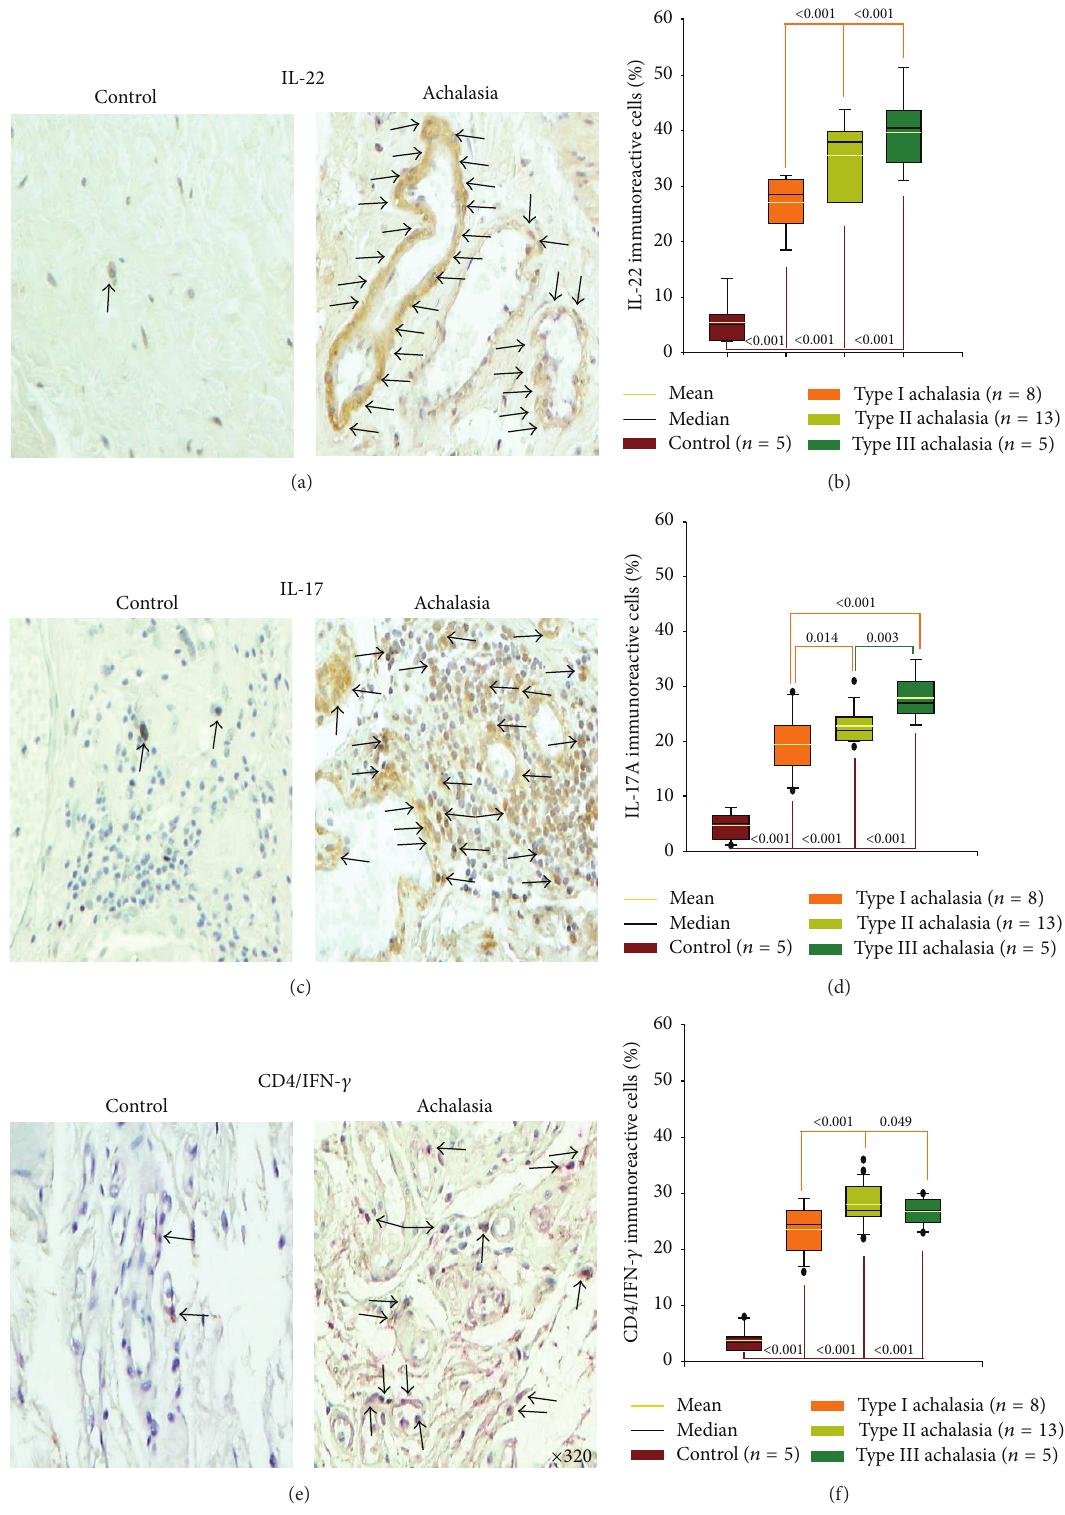
Figure 2: Proinflammatory/antifibrogenic cytokine expression in achalasia. Immunohistochemistry for (a) IL-22, (c) IL-17, and (e) CD4/IFN- 𝛾 T cells in control and achalasia sections. Arrows depict immunoreactive cells. Original magnification was × 320. Results are expressed as mean (yellow line), median (black line), and 5th/95th percentiles of (b) IL-22 + , (d) IL-17 + , and (f) CD4/IFN- 𝛾 + T